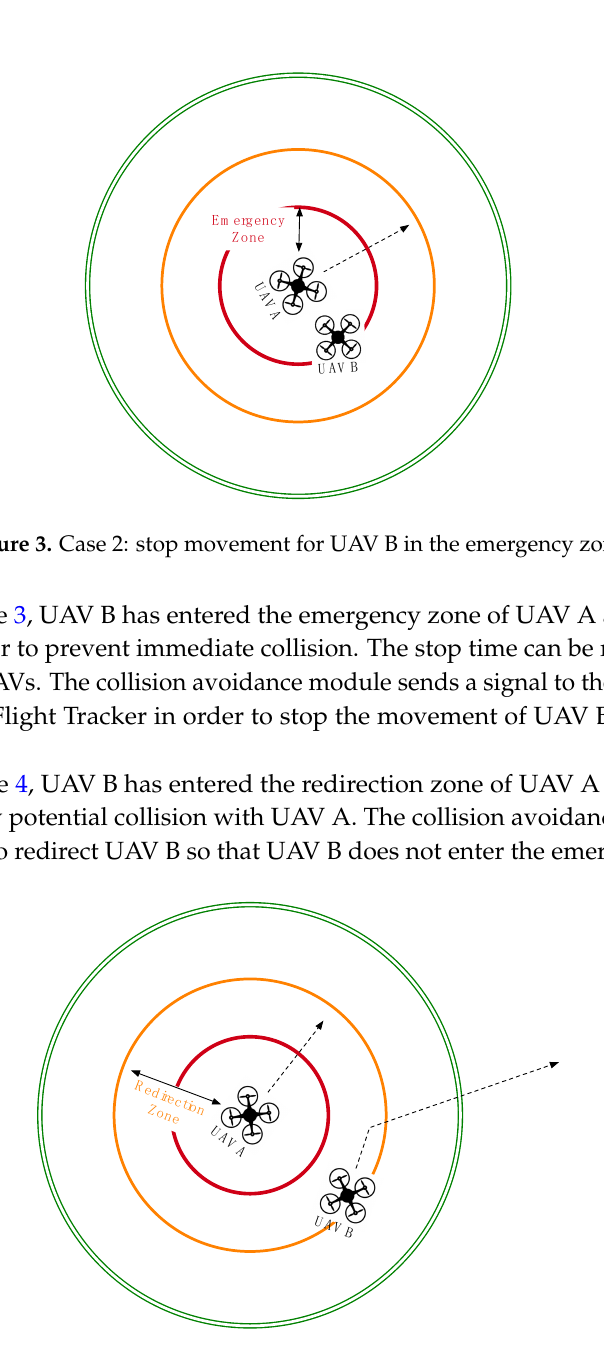
Figure 4. Case 3: change flight path of UAV in the redirection zone.